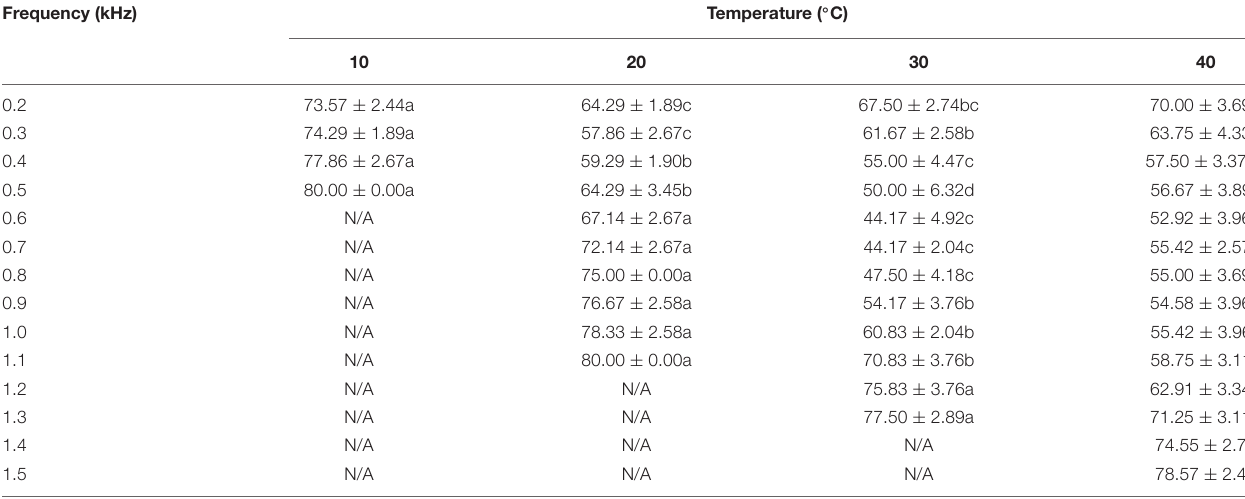
TABLE 3 | Differences in the auditory brainstem response (ABR) threshold of Trachemys scripta elegans at each stimulus frequency among the temperature groups. Frequency (kHz)